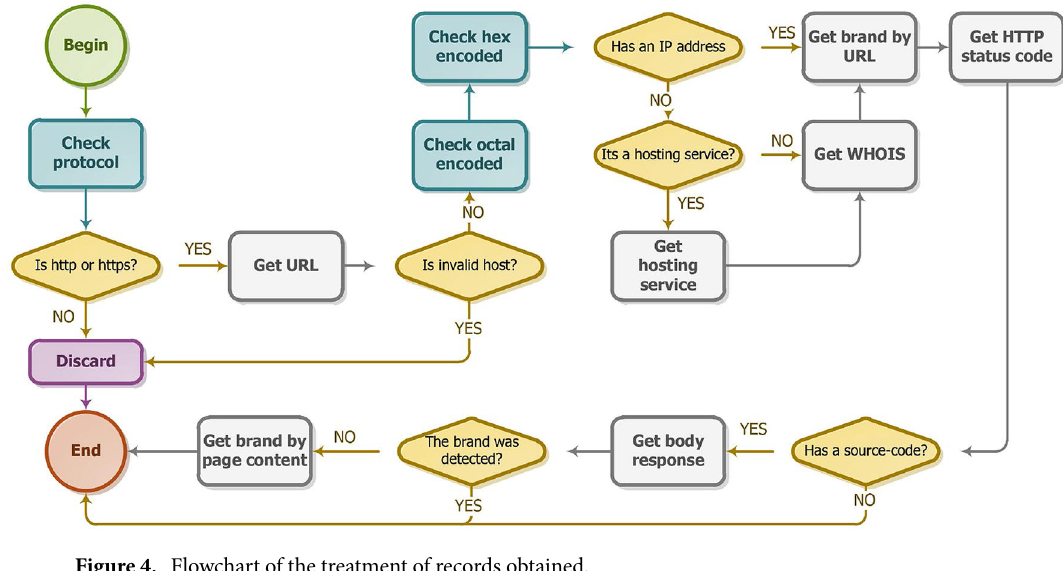
Figure 4. Flowchart of the treatment of records obtained.